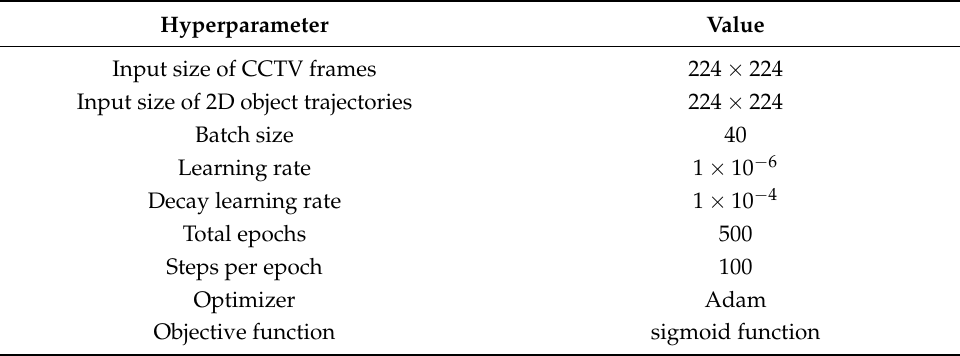
Table 2. Parameters for training the proposed hybrid method. Hyperparameter